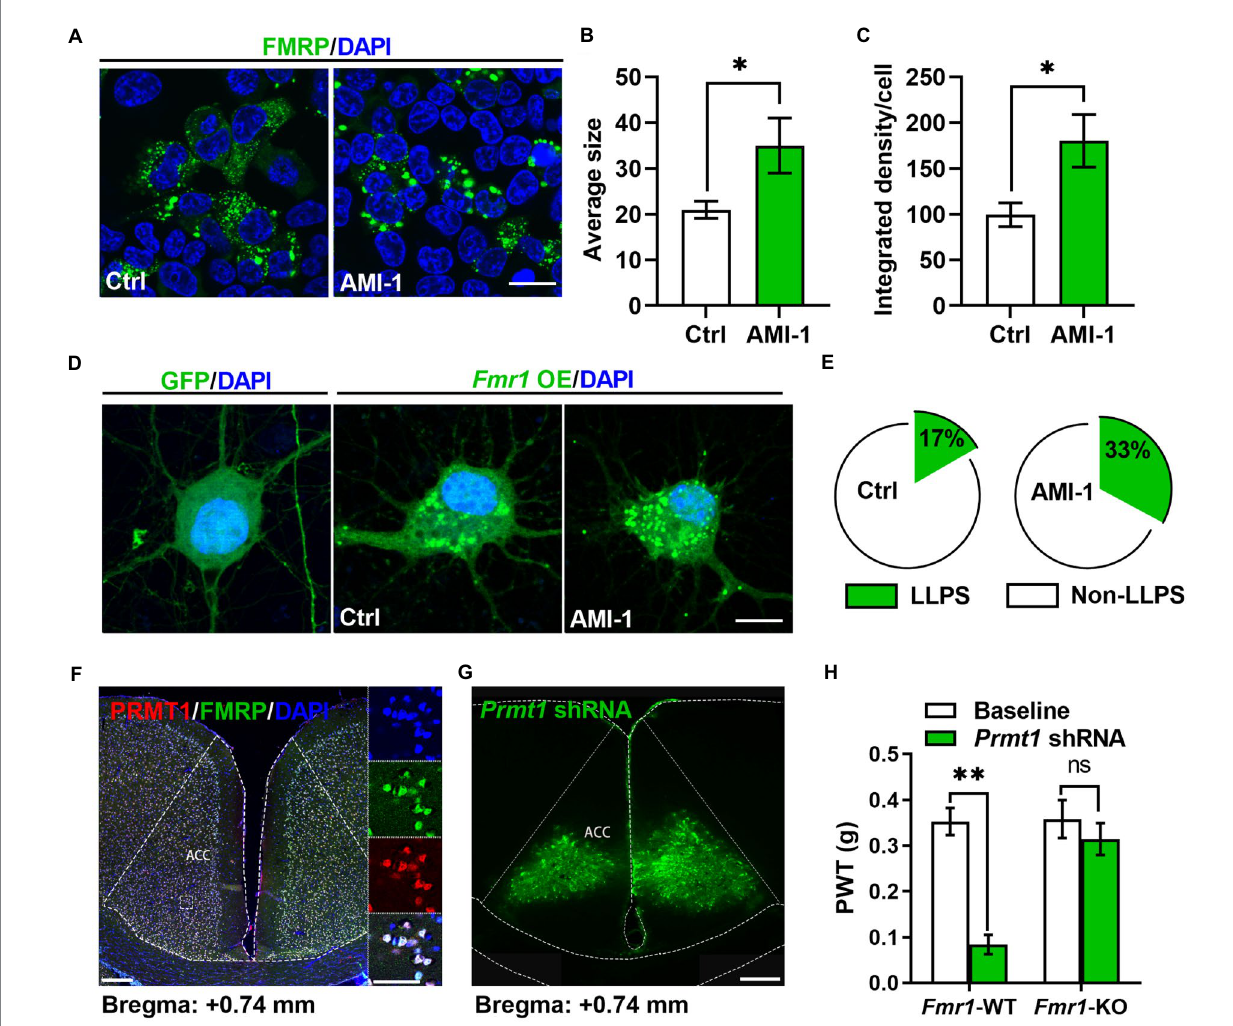
FIGURE 3 FMRP was involved in the development of peripheral hypersensitivity induced by PRMT1 downregulation. (A) Representative examples of control (Ctrl, left) and the application of AMI-1 (right) of FMRP-GFP in HEK-293 T cells. Scale bar, 20 μ m. (B) The average size of the condensed FMRP-GFP clusters in Ctrl and AMI-1 groups (Ctrl: n = 8, AMI-1: n = 7; unpaired t -test, p = 0.0338; * p < 0.05). (C) The integrated density of the condensed FMRP-GFP clusters in Ctrl and AMI-1 groups (Ctrl: n = 8, AMI-1: n = 7; unpaired t -test, p = 0.0185; * p < 0.05). (D) Representative examples of GFP (left), Ctrl (middle, transfected FMRP-GFP) and the application of AMI-1 (right, transfected FMRP-GFP) of FMRP-GFP in the cultured neurons. Scale bar, 10 μ m. (E) The percentage of condensed FMRP in the FMRP-GFP clusters after applying solvent (Ctrl group, left) or AMI-1 (right). LLPS: liquid-liquid phase separation; Non-LLPS: